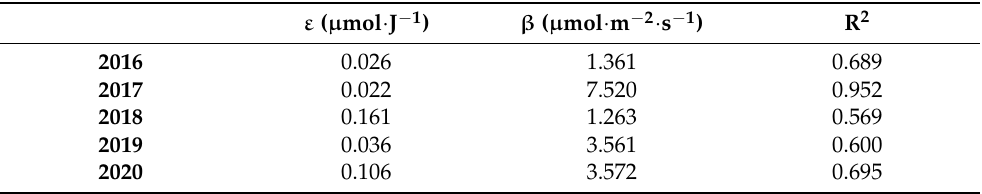
Table 6. Light–response curves parameters ε and β (Equation (3) and Figure 6) as well as the coefficient of determination R 2 of the approximation ( p < 0.001) for March